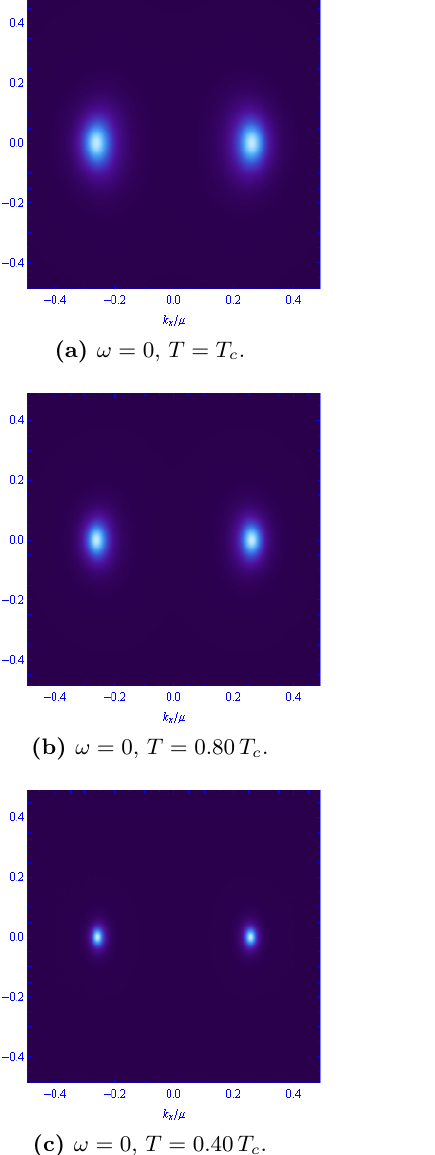
Figure 16. The spectral function at (cid:12)xed (cid:21) = 0 : 80 > (cid:21) c . Left: the spectral surface ! = 0 at di(cid:11)erent temperatures. Right: (1) (cid:26) as a function of ! at ( k x ; k y ) = = ( k (cid:3) ; 0), notice that the black curve ( T = 0) also presents a delta-like peak at ! = 0 which is not depicted in the (cid:12)gure; (2) (cid:26) as a function of ! at ( k x ; k y ) =(cid:22) = (0 : 20 ; 0 : 10); (3) (cid:26) as a function of ! at ( k x ; k y ) =(cid:22) = (0 : 20 ; 0 : 40). Each graph in these plots corresponds to the temperatures: T = T c (red), T = 0 : 90 T c (orange), T = 0 : 90 T c (yellow), T = 0 : 80 T c (green), T = 0 : 40 T c (blue), T = 0